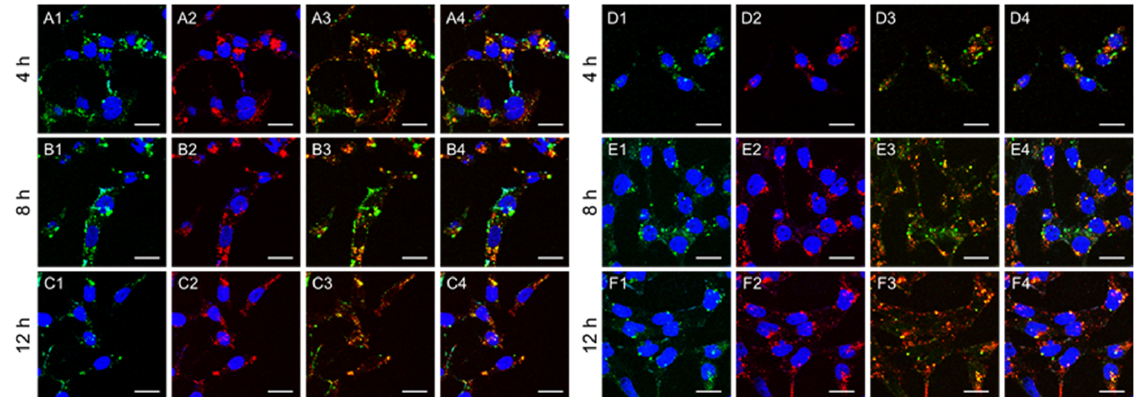
Figure 9. Endosomal escape of Lipo2000@siRNA-Cy5 (A–C) and GNS-P@siRNA-Cy5 (D–F) for 4 h, 8 h and 12 h by CLSM. The nucleus was stained with Hoechst 33342 (blue signal), siRNA was labeled by Cy5 (red signal) and the endosome was stained with LysoTracker Green (green signal). (A1–F1), overlay of endosome and nucleus; (A2–F2), overlay of siRNA and nucleus; (A3–F3), overlay of endosome and siRNA; (A4–F4), overlay of endosome, siRNA and nucleus. The scale bar was 20 µ